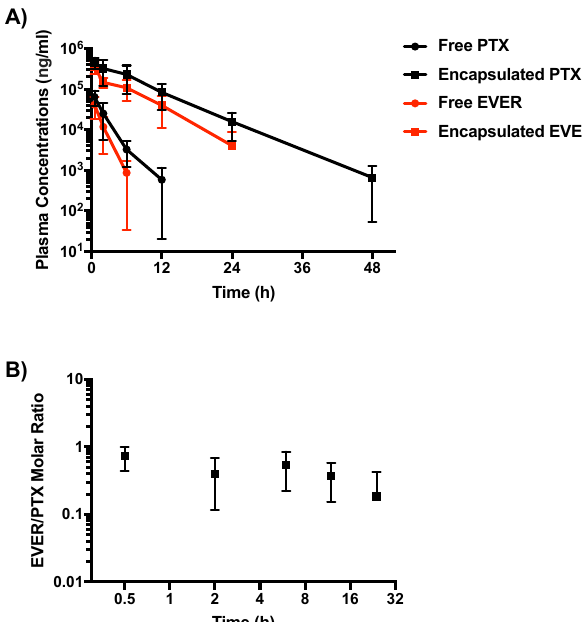
Figure 1. ( A ) Plasma concentrations of paclitaxel (PTX) and everolimus (EVER) after single intravenous administration of dual-targeted PTX + EVER-loaded nanoparticles (Dual-NPs) or free PTX + EVER combination to healthy BALB / c female mice at a PTX-equivalent dose of 15 mg / kg and EVER-equivalent dose of 7.5 mg / kg. ( B ) EVER:PTX molar ratio of drugs released from Dual-NPs in the plasma. ( n = 5). Table 2. Pharmacokinetics parameters for the plasma concentrations of paclitaxel (PTX) and everolimus (EVER) after a single intravenous administration of dual-targeted PTX + EVER-loaded nanoparticles (Dual-NPs) versus free PTX + EVER combination to healthy BALB / c female mice.